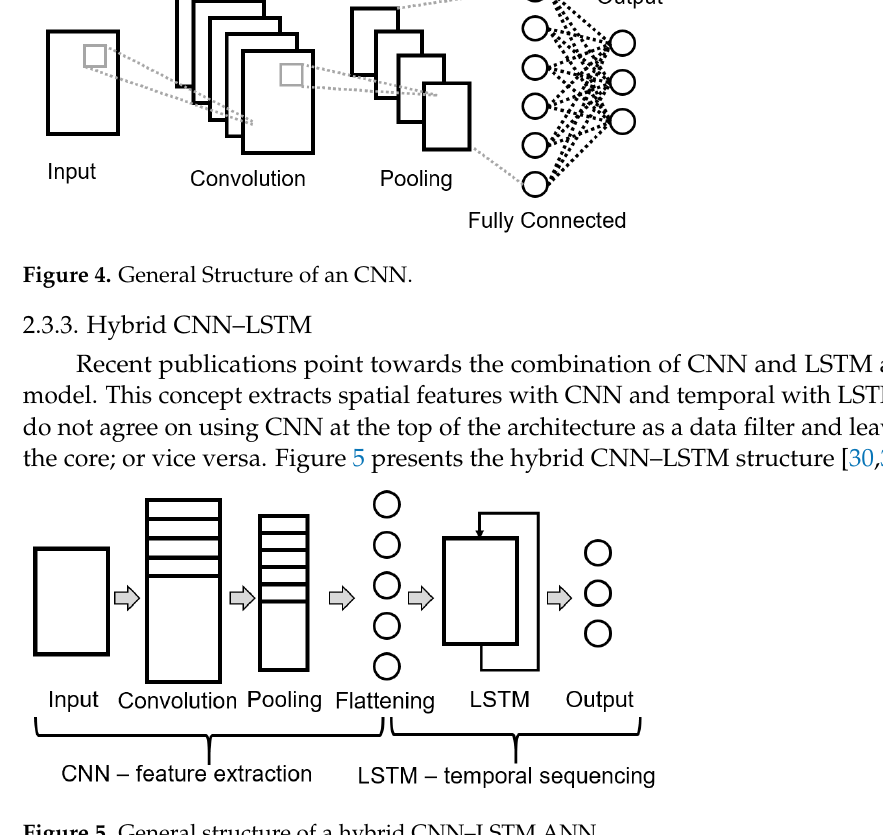
Figure 5. General structure of a hybrid CNN–LSTM